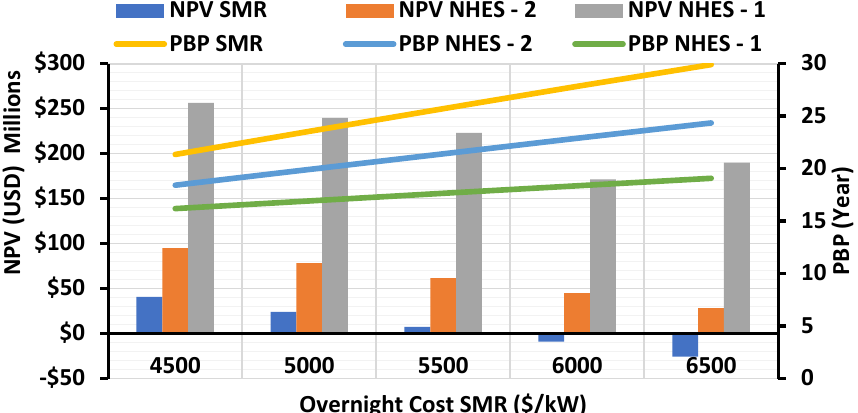
Figure 17. NPV and PBP vs. overnight cost of advanced SMR for New England